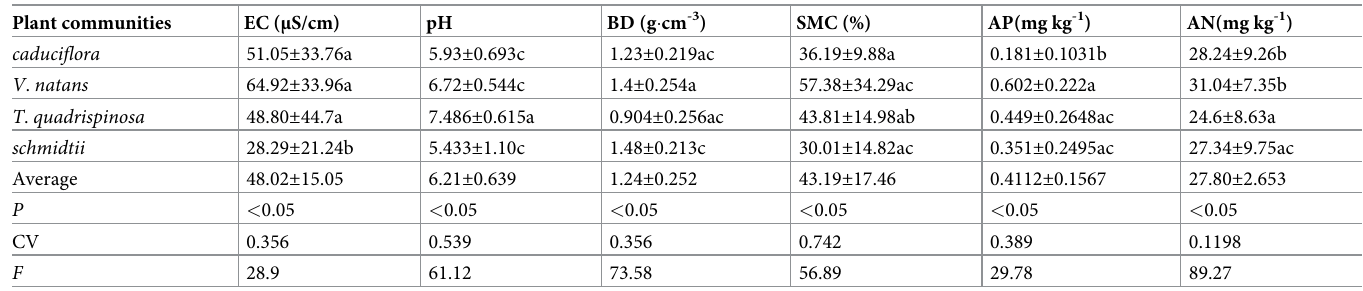
Table 3. Basic soil characteristics (Mean ± SD) in different plant communities in Shengjin Lake wetland. Plant communities